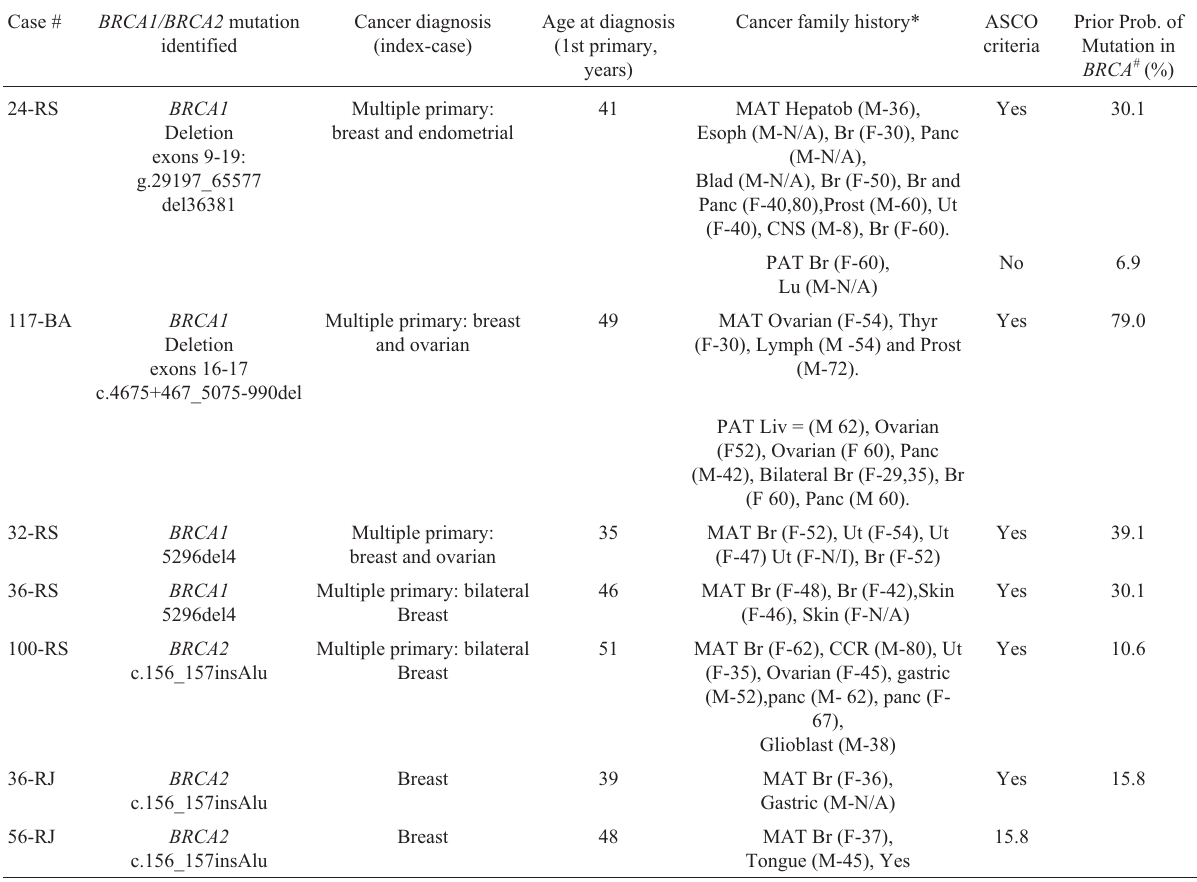
Table 2 - Clinical features of the seven probands with germline BRCA